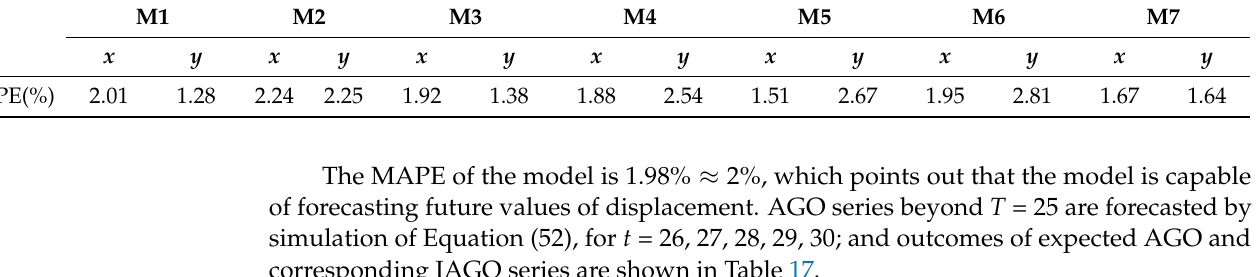
Table 17. Expected AGO and corresponding IAGO outcomes for t = 25, 26, . . . , 30.